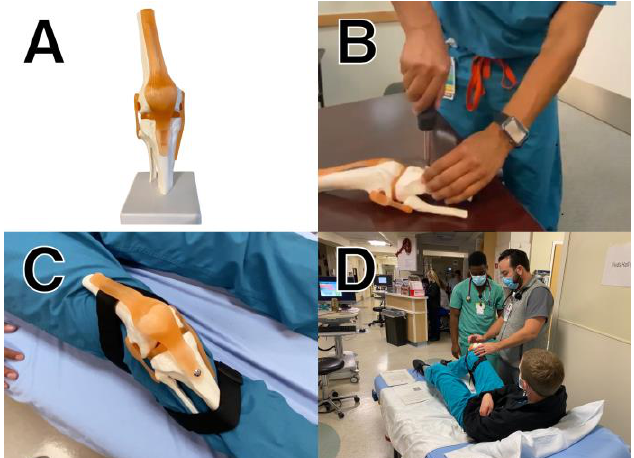
Figure. The base of the trainer is an anatomic knee model (A). The “patellar tendon” is removed and reattached with a screw so that the tendon can rotate laterally and allow dislocation (B). Straps are attached to make the trainer wearable (C). We deployed the training in our pediatric emergency department